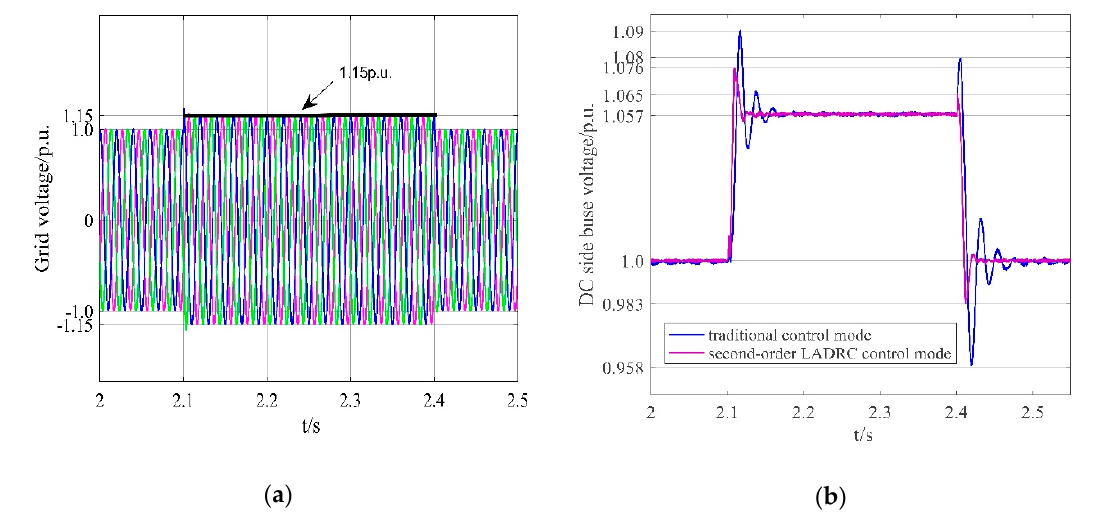
Figure 10. DC side bus voltage waveform under two control modes when the grid voltage symmetric swells by 15%. ( a ) grid voltage waveform; ( b ) DC side bus voltage.